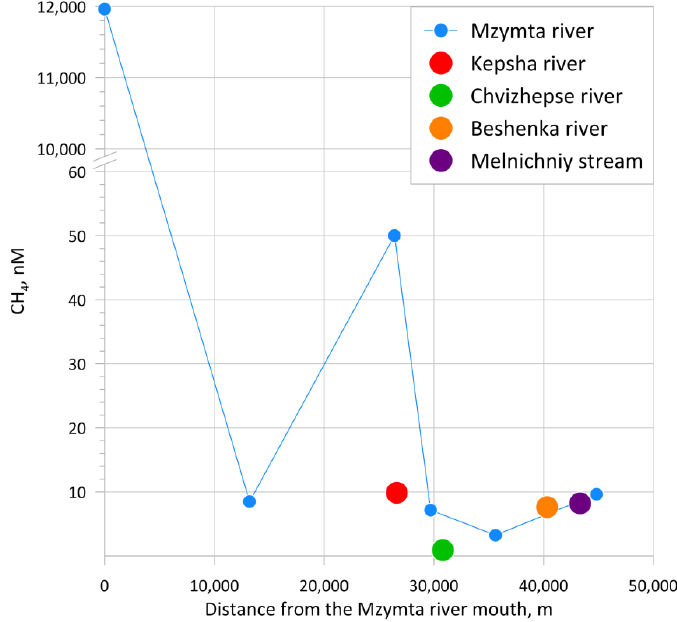
Figure 4. The dissolved methane content in freshwaters in the region of Sochi, May 2013.